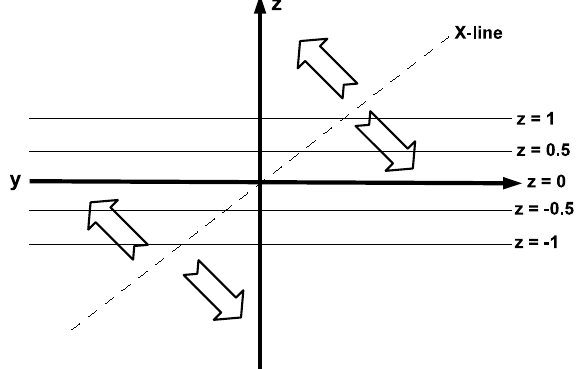
Fig. 2. Sketch of the magnetopause for the y - z plane. The tilted dashed line indicates the X line. The arrows represent the flow leav- ing the reconnection line. The lines at z = + 1, + 0.5, 0, − 0.5, and − 1 R E indicate the z cuts shown in Fig.